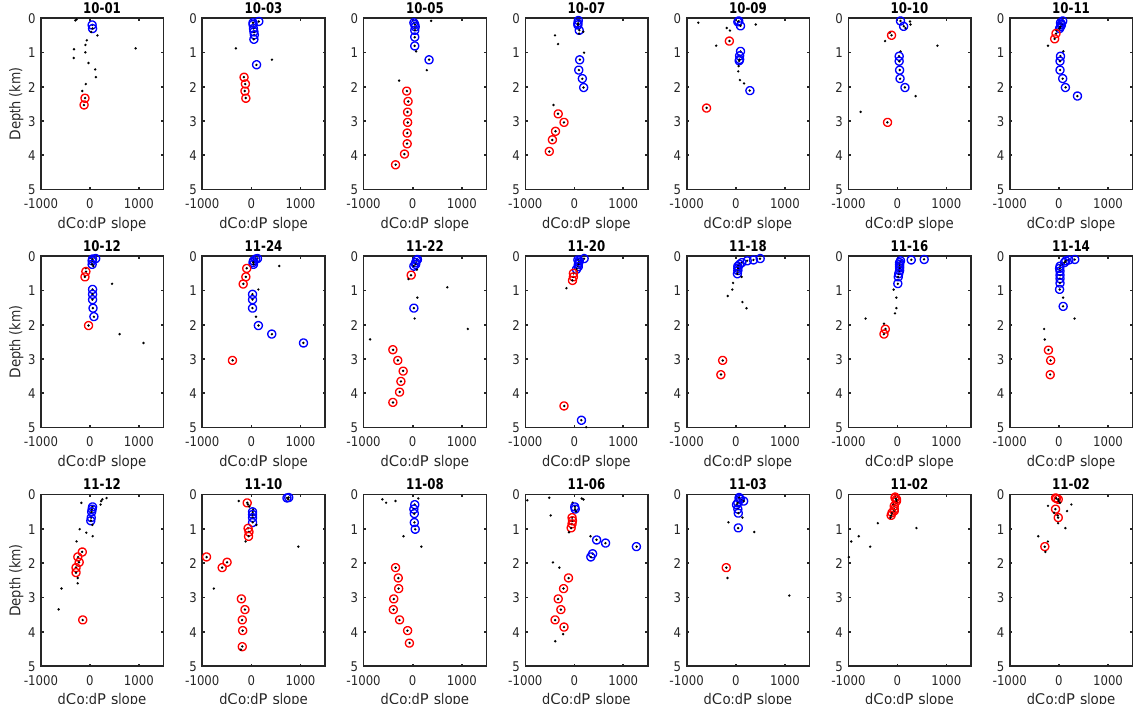
Figure 6. Vertical profiles of dCo:P stoichiometry, as calculated by five-point linear regressions (see “Materials and methods”) for each of the GA03/3_e stations with stations listed above by expedition year (first two digits for USGT10 and 11) and station number (last two digits), separated by a dash. Blue symbols indicate positive slopes with associated r values >0.7. Red symbols indicate slopes with associated r values < − 0.7. There was significant geographical heterogeneity in stoichiometry. Most stations showed nutrient-like positive slopes in the upper water column, and scavenged negative slopes in the mesopelagic and deeper depths. Other variations with some stations showing only scavenged negative (red) slopes (11-02, 11-01), particularly in the North American coastal region, while other regions show alternating positive and negative slopes, likely indicative of subducted water masses (11-06, 11-24). Also, in the photic zone of stations 11–18, 11–16, and 11–14 there is an increase (an acceleration) of dCo:P stoichiometries towards the surface. Some data points do not appear (e.g., stations 11–18 and 11–20) due to being off-scale and below